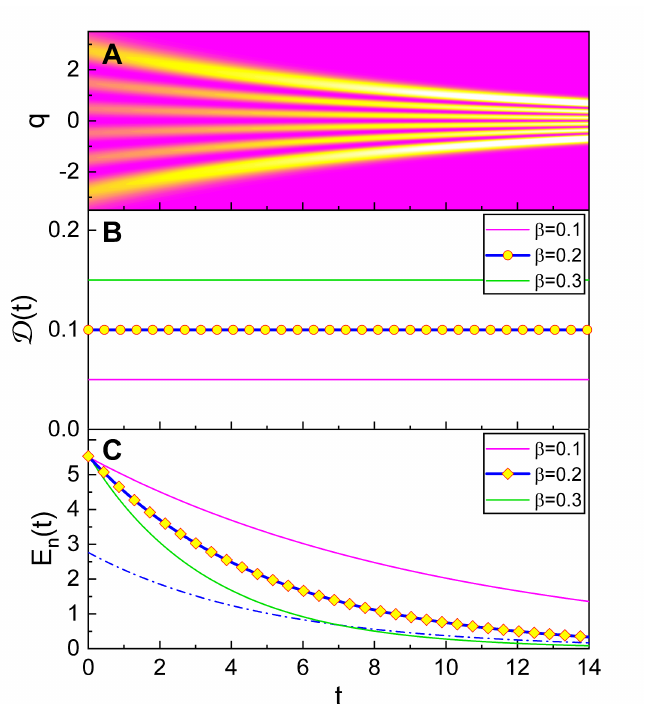
Figure 1. Contour plot of the probability density |(cid:104) q | ψ n (cid:105) D | 2 ( A ) as a function of q and t for the quantum wave given in Equation (24), where we have chosen β = 0.2; the corresponding temporal evolutions of the ratio D ( t ) ( B ) and the quantum energy E n ( t ) ( C ) for several different values of β . The extra line in ( C ), i.e., the dash-dot line is quantum electric energy T n ( t ) for the case of β = 0.2, whose value is in fact the same as the magnetic energy V n ( t ) . We have used n = 5, ω 0 = 1, ¯ h = 1, and (cid:101) = 1. For convenience, we take all values being dimensionless for this and subsequent figures. This figure illustrates gradual wave